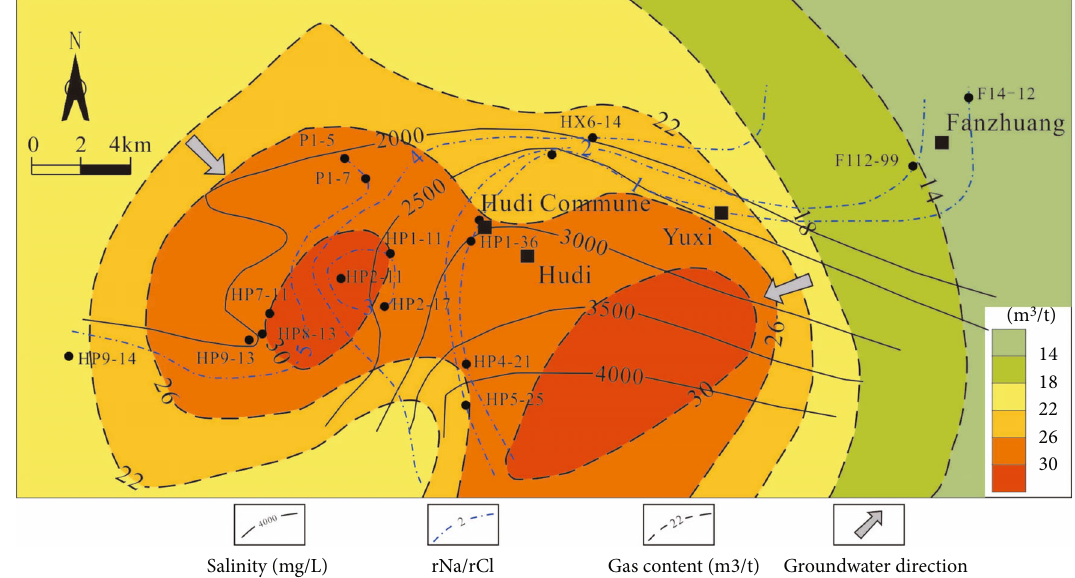
Figure 5: Relationship between the salinity of produced water (constant ratio) and the CBM in the south of the Fanzhuang